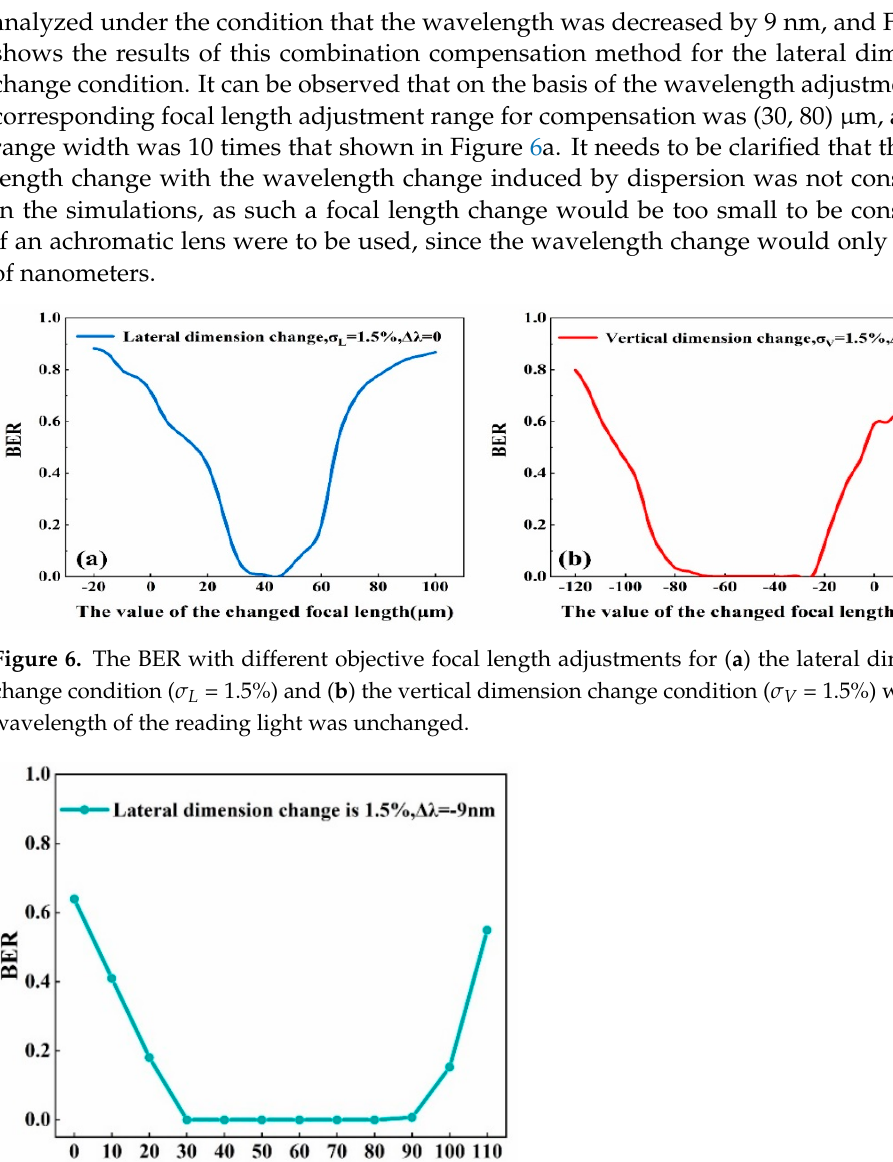
Figure 6. The BER with different objective focal length adjustments for ( a ) the lateral dimension change condition ( σ L = 1.5%) and ( b ) the vertical dimension change condition ( σ V = 1.5%) when the wavelength of the reading light was unchanged.